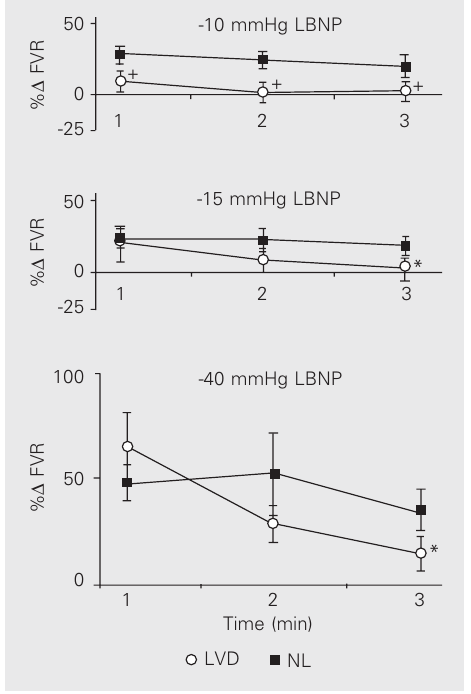
Figure 1. Minute-to-minute changes in forearm vascular re- sistance during the first 3 min at -10, -15 and -40 mmHg of lower body negative